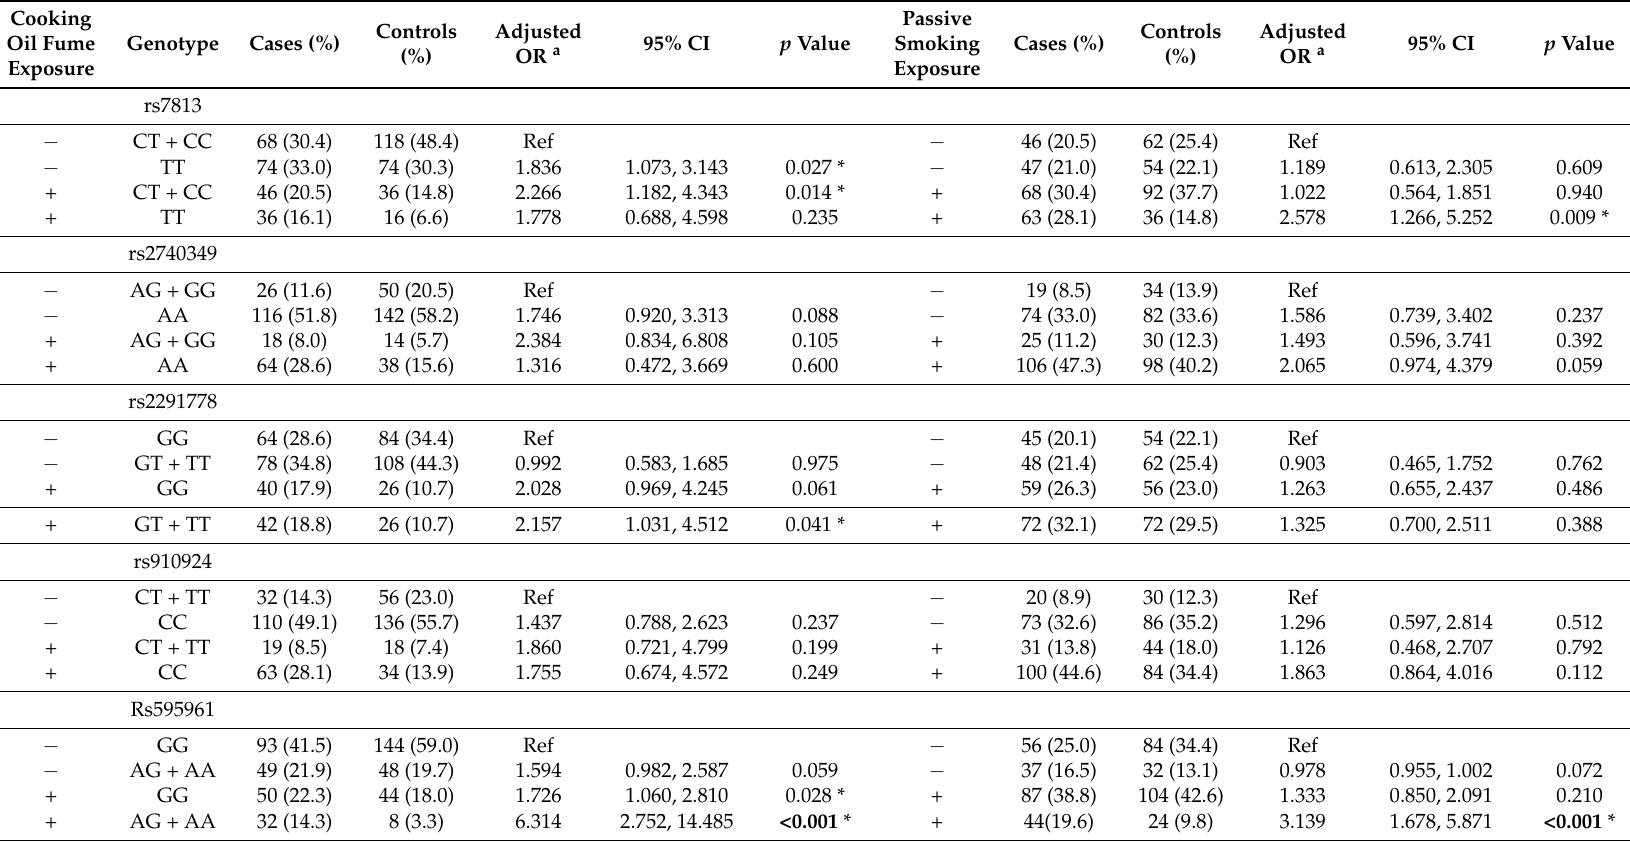
Table 7. Interaction of five SNPs and environmental risk factors on lung cancer